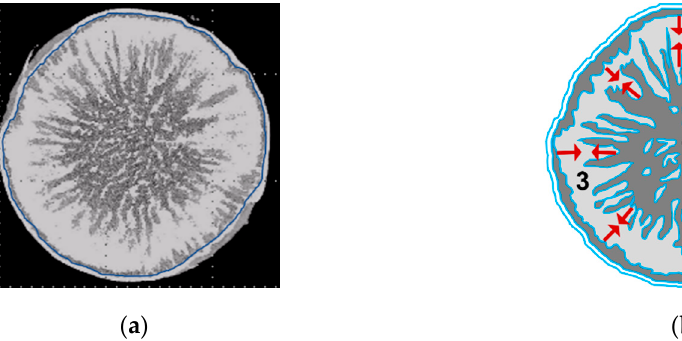
Figure 4. ( a ) The horizontal cut through the tomography image of the partially dried sample (after 11.5 h of drying) reveals the dry zones. The light-gray regions contain water and maltodextrin (it is noted that maltodextrin and heavy water are not distinguished from this image). ( b ) Schematic illustration of the different zones that are distinguished from the tomography image. The red arrows depict the expansion direction of the dry zones. 1: accumulation of maltodextrin inside the peripheral maltodextrin belt; 2: peripheral sublimation zone with fractal front; 3: ring of frozen water and maltodextrin; 4: sublimation fingering zone.